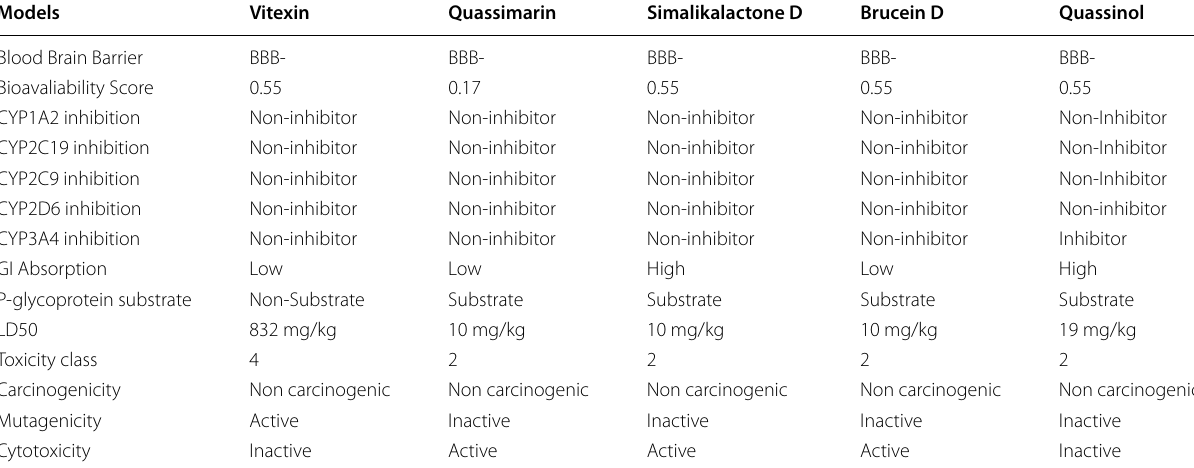
Table 4 The bio-availability, pharmacokinetic properties and Cytochrome P450 metabolizing enzymes inhibitory potentials of selected Quassia amara phytochemical constituent